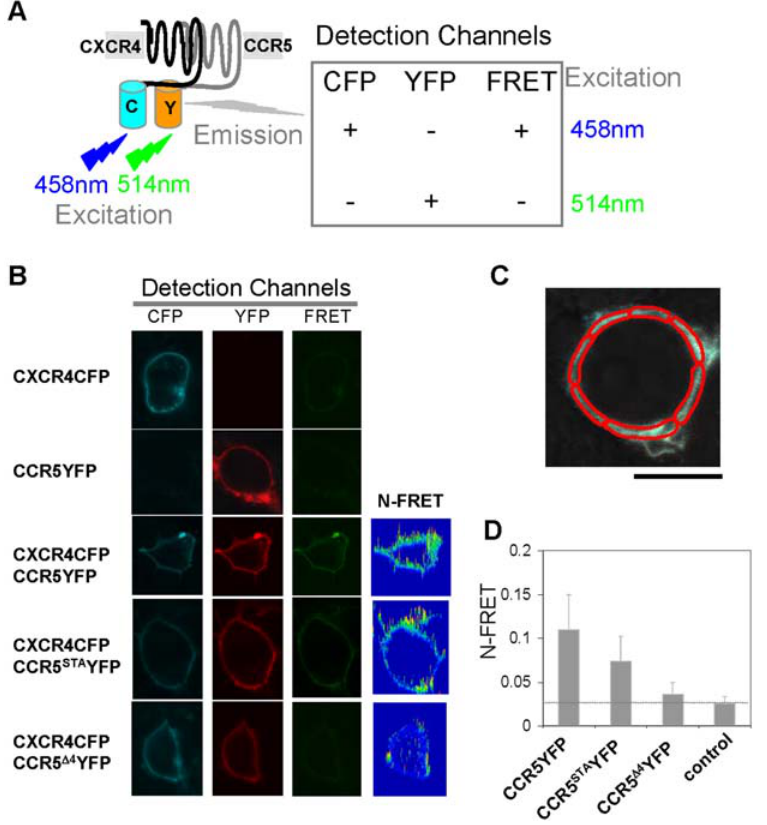
Figure 4. An analysis of CXCR4 and CCR5 association on the surface of live cells by FRET imaging. A. Schematic diagram of FRET measurement between CFP-tagged CXCR4 and YFP-tagged CCR5. When cells were excited at 458 nm, emissions are simultaneously recorded in CFP channel and FRET channel, and when cells were excited at 514 nm, emissions were recorded in YFP channels. We used multi-channel and line- scanning mode so that images of three channels were recorded simultaneously. Cells expressing only CXCR4CFP or CCR5YFP were used as controls for calculating real FRET efficiency that is expressed as normalized FRET (N-FRET). B. Images of cells expressing only CXCR4CFP or CCR5YFP; CXCR4CFP with CCR5YFP, and CCR5 STA YFP or CCR5 D 4 YFP. N-FRET images show FRET intensities. C. FRET efficiency, N-FRET, in the plasma membrane was measured in selected regions of interest (ROIs). One example is shown. D. Quantitative analysis of N-FRET on cells expressing CXCR4CFP and CCR5YFP (n=198), CCR5 STA YFP (n=156) or CCR5 D 4 YFP (n=148) is shown as means 6 S.D. Cells expressing IL17RA-YFP and TNFR-CFP (n=58) were used as negative control. Statistical significance was assessed using a t-test.